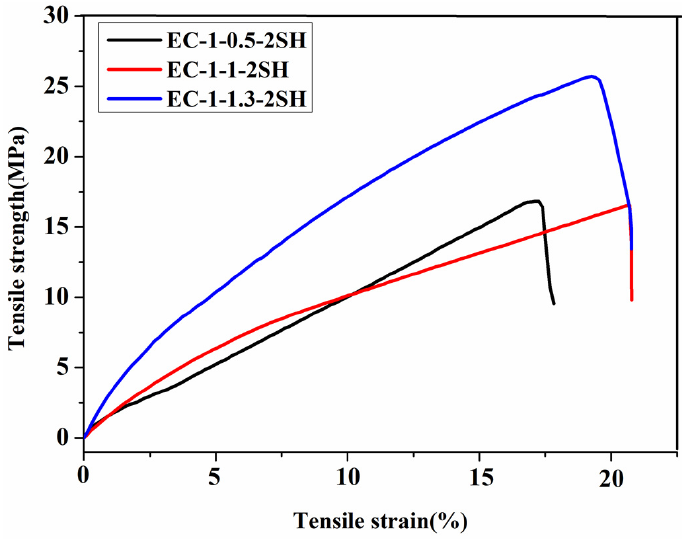
Figure 14. Tensile stress and strain of the EC cross − linked polymers using 3,6 − Dioxa − 1,8 − octanedithiol as the cross − linker.